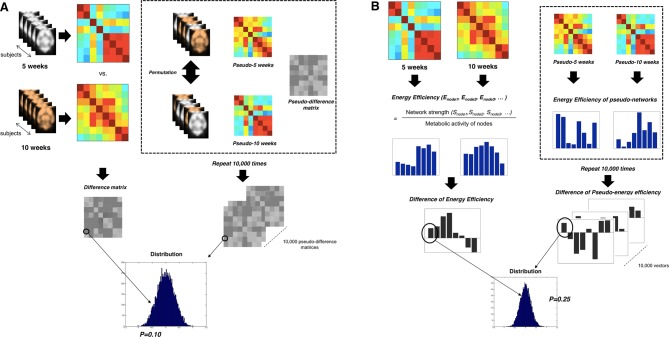
Statistical analysis for metabolic connectivity maturation based on permutation test.We analyzed different pairwise connections between rats aged 5 vs 10 weeks and 10 vs.  15 weeks. (A) Correlation matrices were generated and their differences were calculated between paired groups, and data of paired groups were permuted 10,000 times to yield the distribution of correlation matrices and their differences (pseudorandom matrices) were obtained from these randomly permuted groups. Type I errors were determined by the comparison of the observed difference matrix with the distribution of pseudo-difference matrices from permuted data. (B) Energy efficiency of nodes of rats aged 5 vs 10 weeks and 10 vs 15 weeks was also compared using the same permutation test as above. Data of paired groups were permuted 10,000 times to yield the distribution of efficiency vector, and their differences (pseudorandom vectors) were obtained from these permuted groups. Type I errors were determined by the comparison of the observed difference vector with the distribution of pseudo-difference vectors from permuted data.